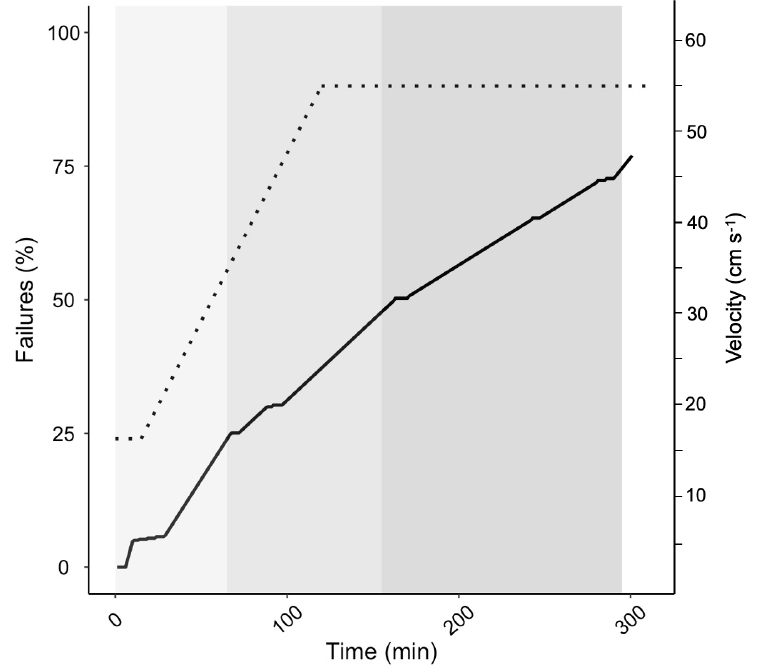
Figure 1. Endurance screening protocol for rainbow trout. Dotted line is water velocity; solid line is cumulative percentage of fish failures. The increasingly shaded regions delineate each failure quartile.